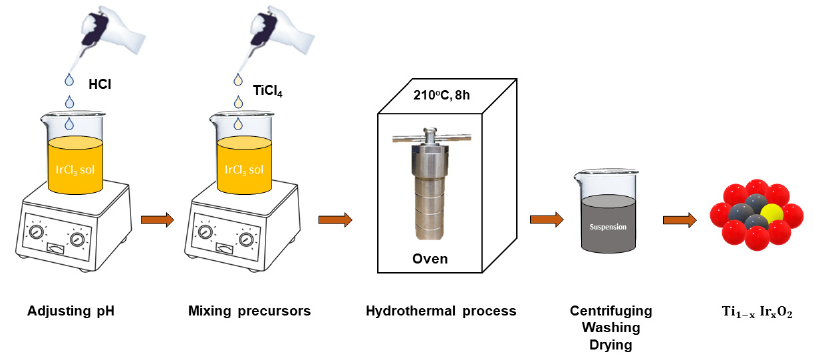
Figure 1. Procedure to synthesize Ir-doped TiO (cid:2870) photocatalysts.